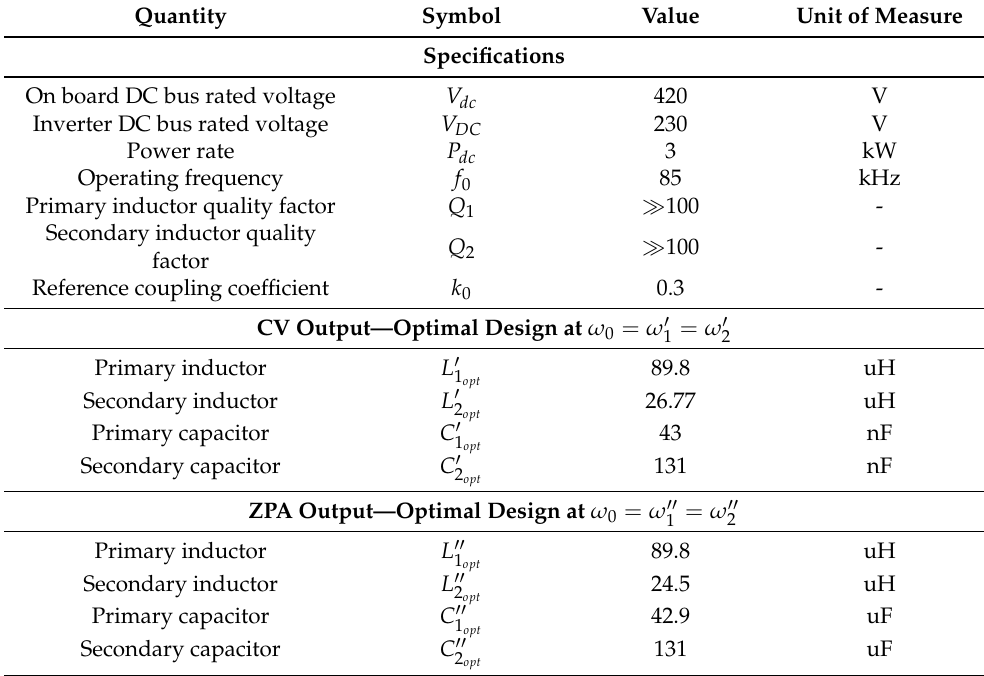
Table 1. Case study system parameters.